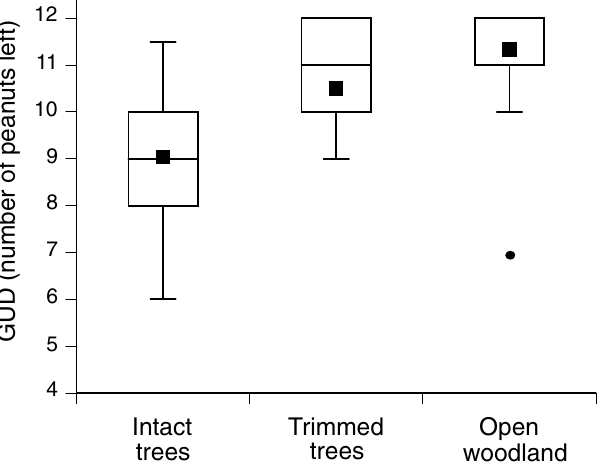
Figure 3. Results from giving-up density (GUD) experiments conducted in January to measure ‘perceived risk’ by rats foraging under ‘Intact’ Chinee Apple trees (with intact foliage), ‘Trimmed’ trees (lower foliage removed) or ‘Open woodland’. The GUD is expressed as mean number of peanut pieces (out of 12) remaining after nocturnal foraging activity. Higher GUD values indicate higher perceived risk and increase with less cover close to the ground (i.e., structural openness of habitat: open woodland > trimmed > intact). Box and whisker plots denote mean, median, minimum, maximum, and interquartile ranges. Plots may have no upper whisker when the upper interquartile range is the same value as the sample’s maximum. All treatment categories were significantly different from each other ( p <